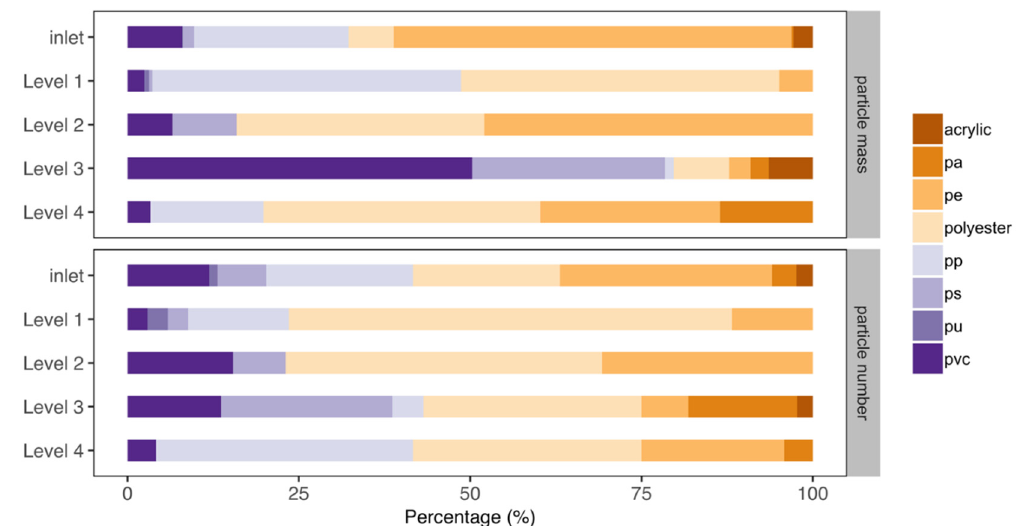
Figure 4. Polymer distribution between the inlet and four filtration levels.